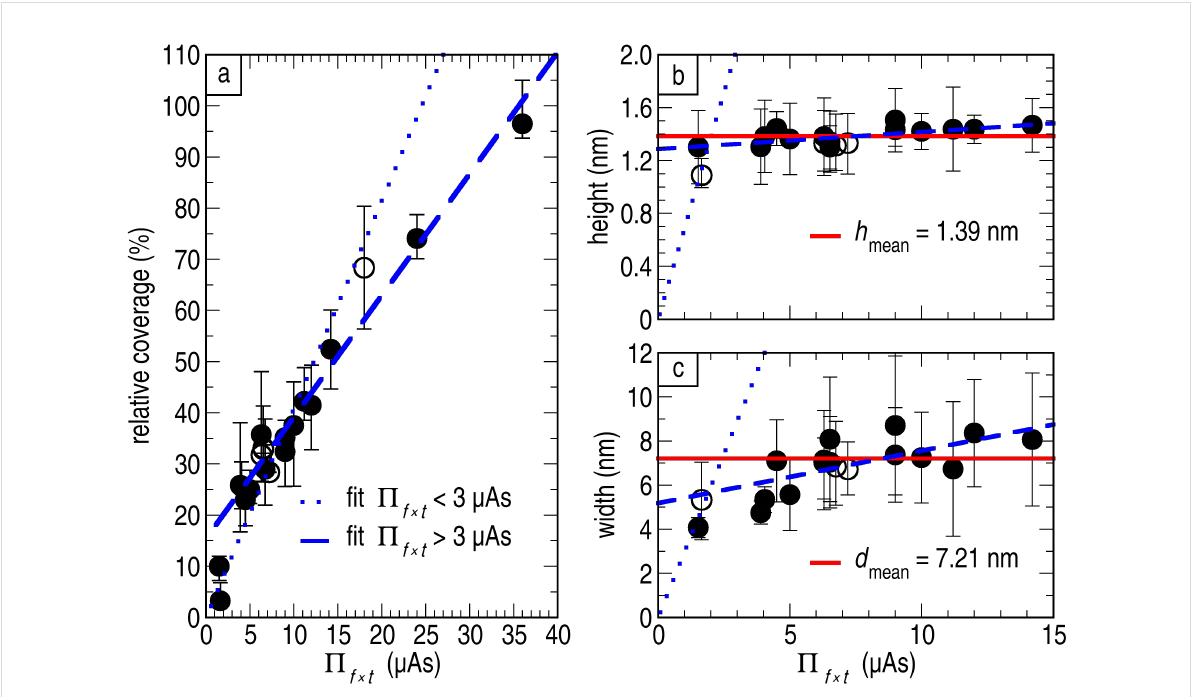
Figure 2: Analysis of the growing behaviour: (a) coverage of the surface, (b) cluster height and (c) cluster width versus Π f × t . Panel (b) and (c) have the same scale on the x -axis. Plotted as the filled symbols are the results obtained by fitting cross sections, as described in the text. The error bars indicate the ±2 σ confidence level. Additional data points are plotted with empty symbols in the graphs to point out the lack of statistics (less than 25 cross sections), accordingly the arithmetic mean value was calculated. The error bars indicate the largest and smallest value obtained from the fit of the individual clusters. For high coverage ( Π f × t ≥ 15 μ As) the cluster–cluster distance was too small for getting reliable values. Thus, we do not have data for the height and the width for these